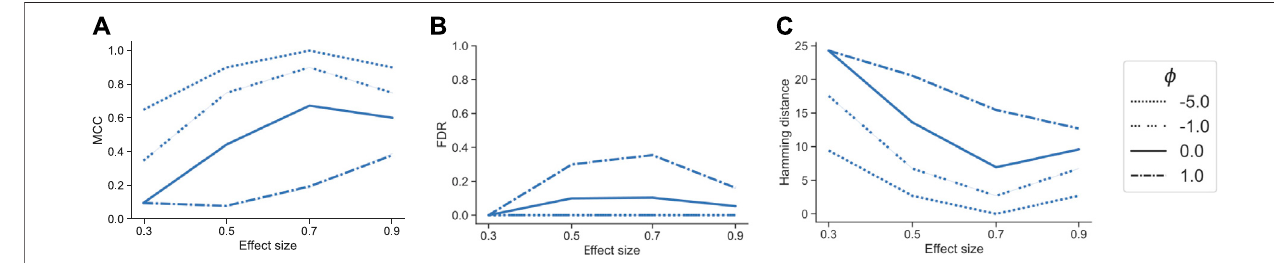
FIGURE3| PerformancecomparisonofdifferentbiassettingsfortascCODAonsimulateddatawiththeeffectbeinglocatedneartherootofthetree,dependingon effect size. Performance measured by (A) Matthews correlation coef fi cient (MCC). (B) False discovery rate (FDR) (C) Hamming distance between ground truth and determined